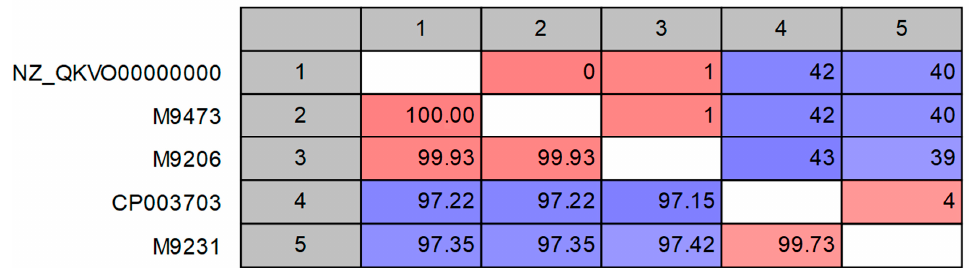
Figure 1. Maximum likelihood phylogenetic tree of the polC polymerase near-complete amino acid sequences (range: 1407-1331 aa) from three samples of the present study (M9231, M9473 and M9206) and various reference samples from GenBank. Percentage bootstrap support of 1000 replicates is shown. The scale bar indicates the average number of substitutions per site.